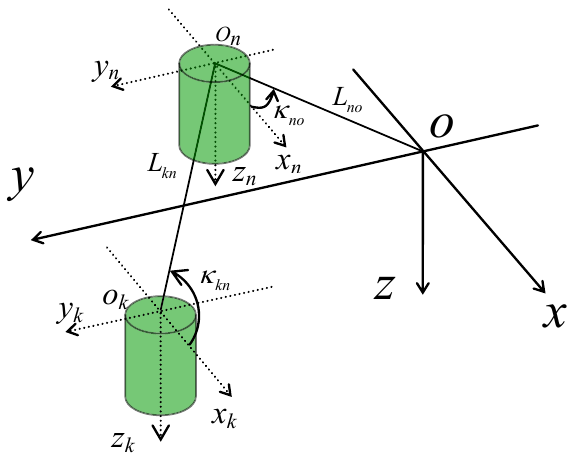
Figure 2. Global and local coordinate